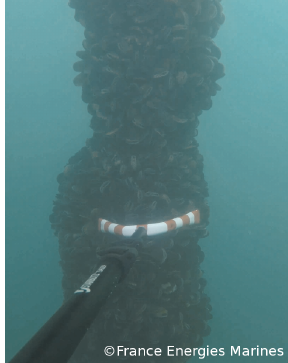
Figure 4. Photograph of bio-colonisation on East cardinal buoy mooring chain of the SEMREV test site in February